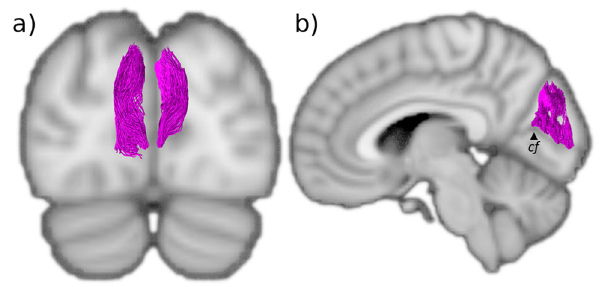
Fig. 3 The stratum proprium cunei (SPC). a Coronal view of the SPC (magenta) that lines the midline of the cuneus. b Sagittal view of the SPC showing how it arises from the superior bank of the calcarine fi ssure. cf: calcarine fi ssure.